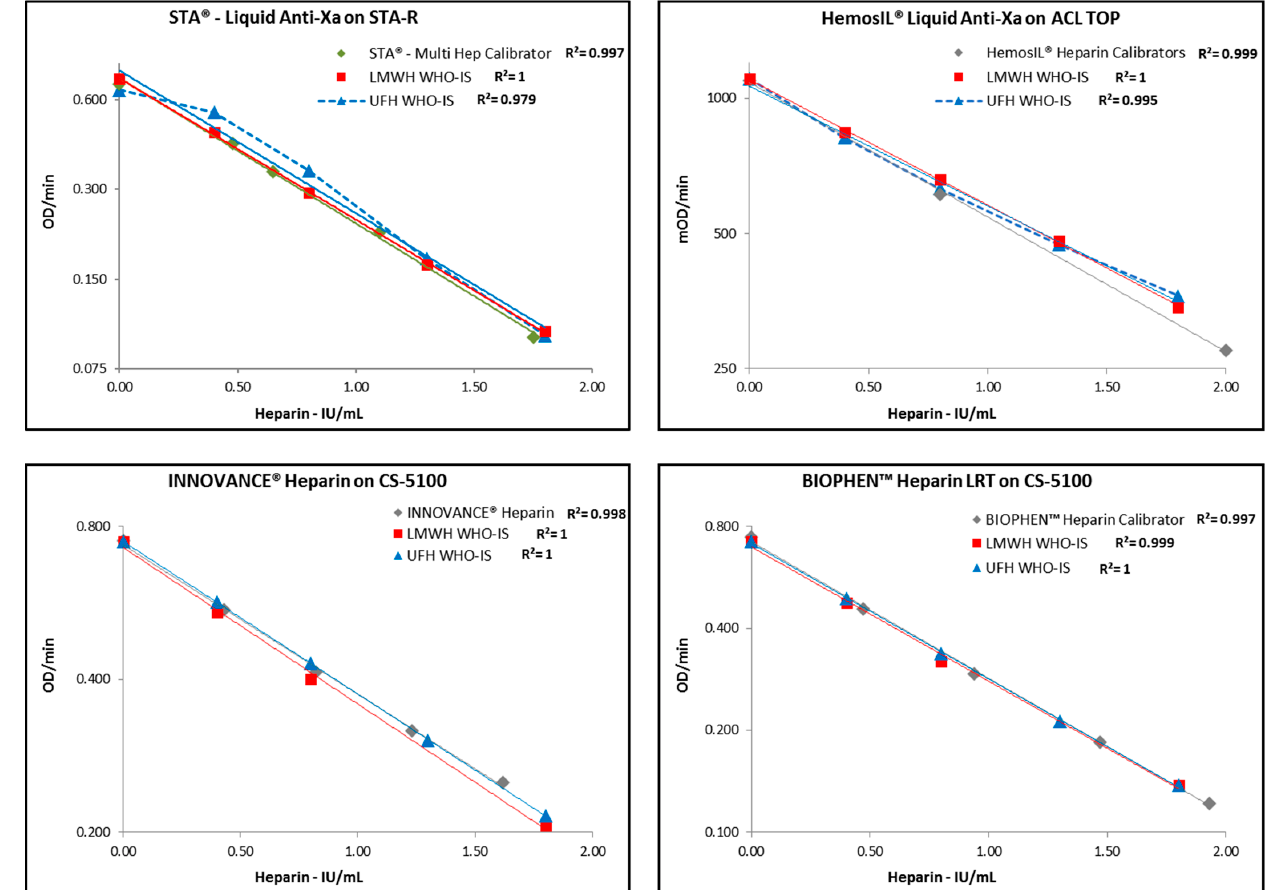
Figure 1. Comparison of calibration curves, tested in duplicate, for each anti-FXa assay used with the manufacturer’s coagulation instrument as compared with the International Standards for UFH or LMWH. Heparin concentrations are on abscissae and change in absorbance per minute (OD/min) on ordinates. Linear regression lines are drawn, and correlation coefficients indicated for each calibration.